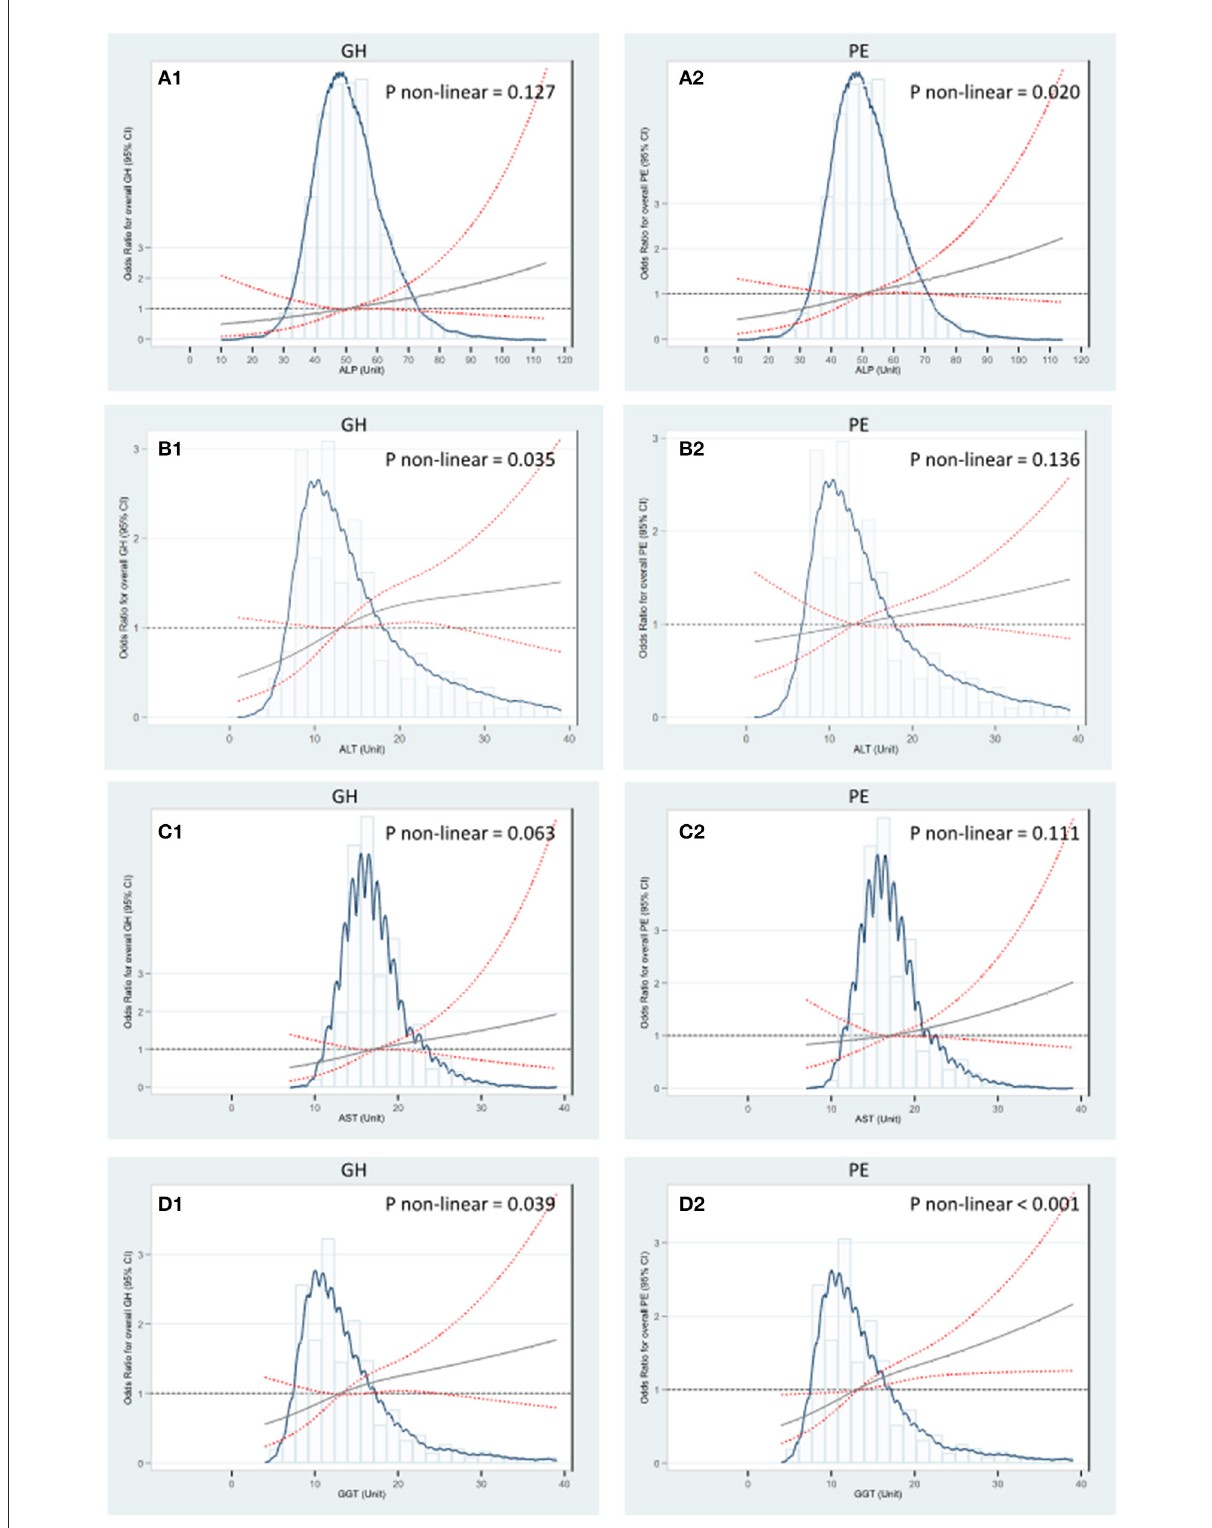
FIGURE3 RCS regression analysis of liver enzyme levels with GH and PE. (A) The median of ALP 50 U/L was selected as the reference level to investigate associations of ALP with